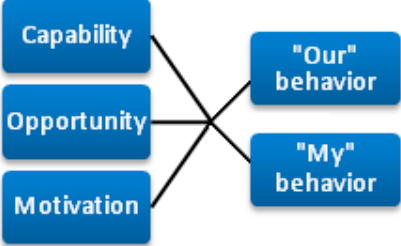
Figure 3. An extended construct of COM-B model for behavioral change in the military.